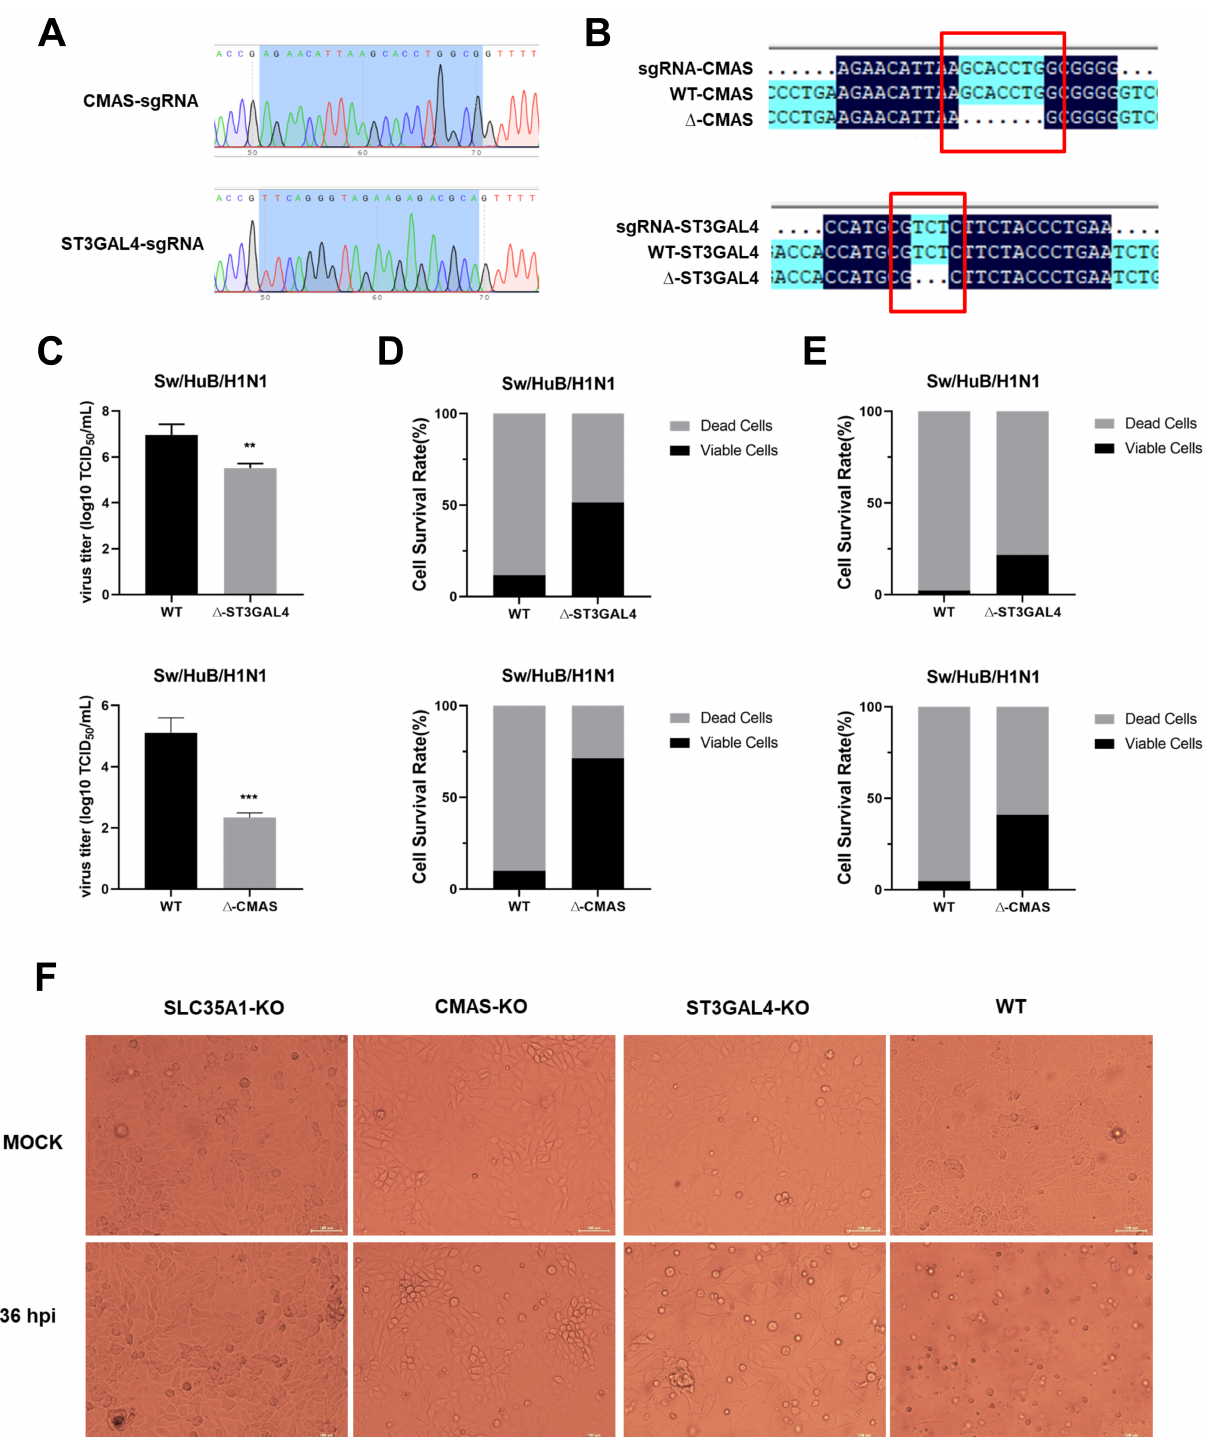
Figure 1. Generation of knockout cell line. ( A ) sgRNA sequencing results. ( B ) Detection of sgRNA knockout efficiency. ( C ) Effect of gene knockout on IAV replication. CMAS -KO, ST3GAL4 -KO and SLC35A1 -KO NPTr cells were generated through the CRISPR/Cas9 system; NPTR-Cas9 NPTr cells were used as wild-type control. WT NPTr cells and KO NPTr cells were infected with Sw/HuB/H1N1 virus (MOI = 0.01). Cell supernatants were collected at 36 hpi, and the virus titers were determined by TCID 50 assay on MDCK cells. (Data from three independent experiments, mean ± SD; ** p < 0.01; *** p < 0.001; two-tailed Student’s t test.) ( D ) MOI = 0.01 or ( E ) MOI = 0.1, WT NPTr cells and KO NPTr cells were infected or not infected with Sw/HuB/H1N1 virus, and the cell survival rate was determined by calculating the ratio of cells number in the infected group divided by the cells number in the uninfected group. ( F ) The survival of each monoclonal cell line at 36 h post-infection with or without Sw/HuB/H1N1 virus. Scale bar = 100 µ